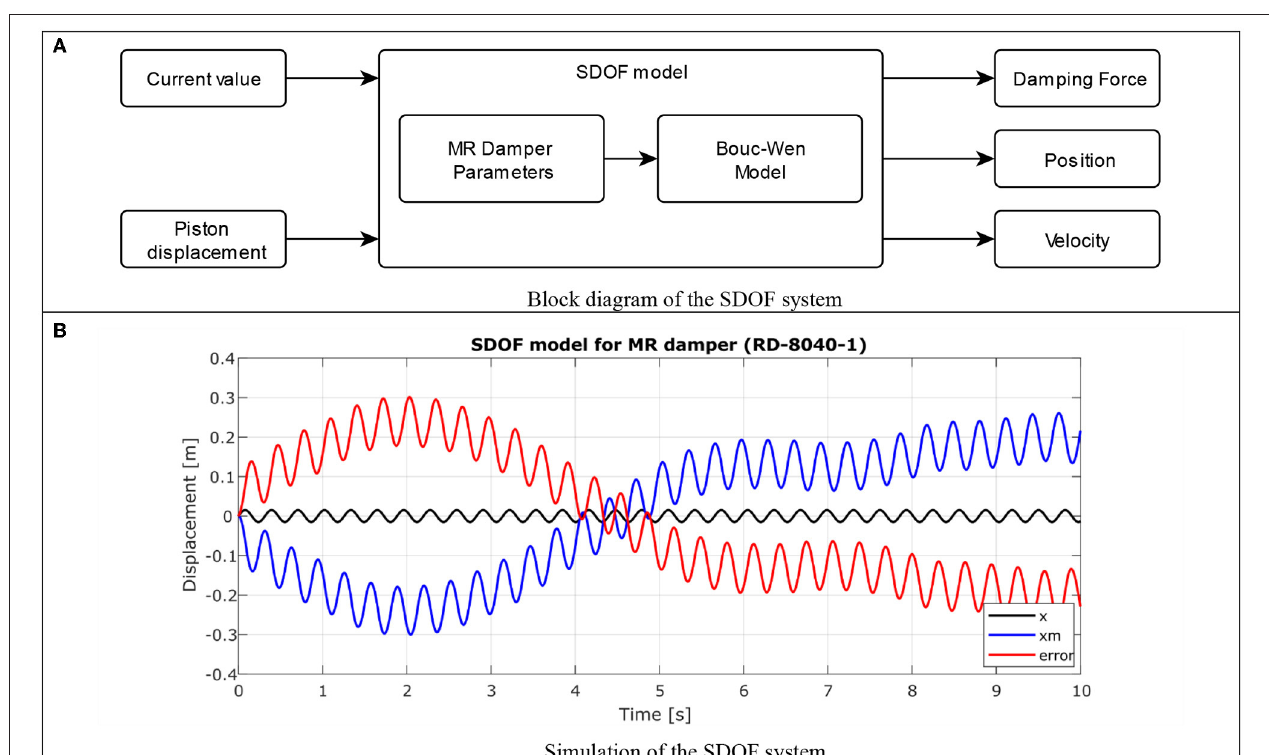
FIGURE 10 | Simulation of single degree of freedom system. (A) Block diagram of the SDOF system. (B) Simulation of the SDOF